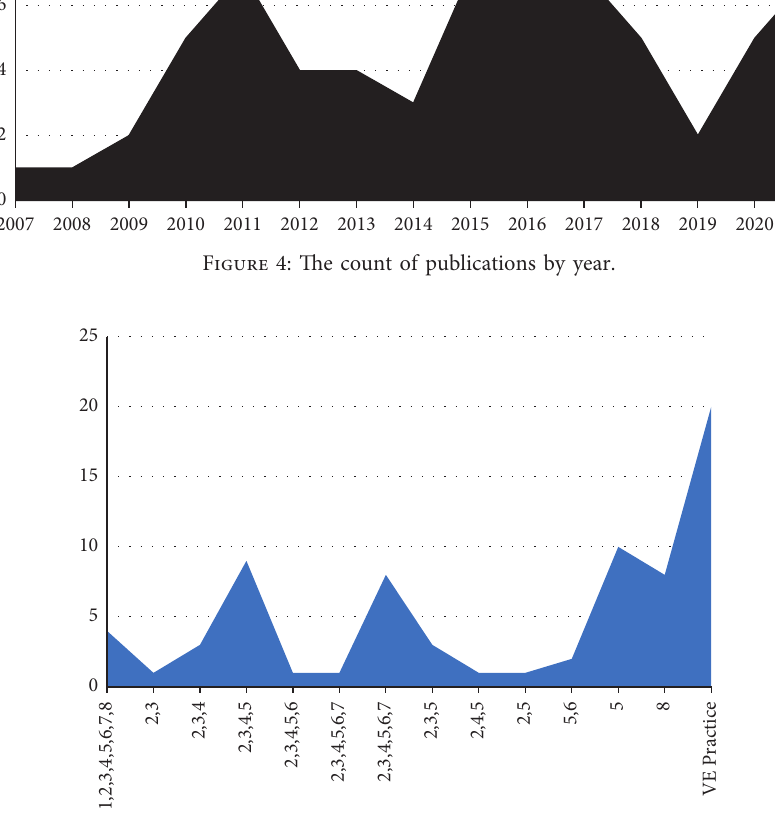
Figure 5: PublicationsbasedonVEworkshopphases.VEworkshopphases—1:preworkshop,2:information,3:function,4:creativity,5:evaluation, 6: development, 7: presentation, 8: postworkshop, and VE practice: general professional practice of VE.